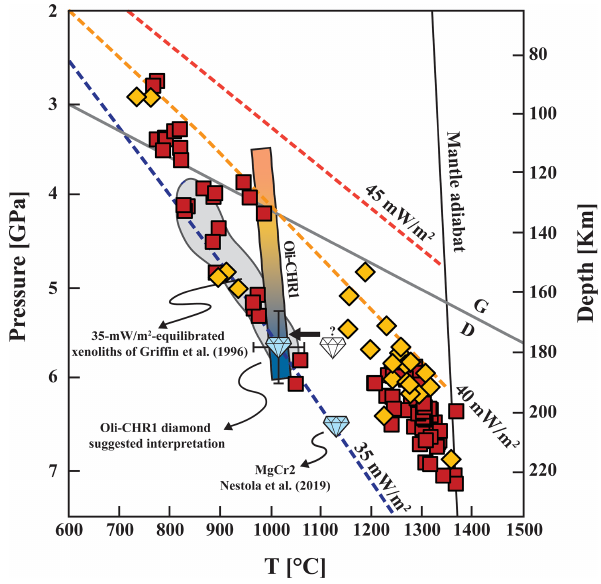
Figure 3. Pressure–temperature diagram showing the distribution of well-equilibrated mantle xenoliths from Udachnaya kimberlite (data source: Tables S1–S2). Red squares indicate the most recent P – T data from Liu et al. (2022), which include a new suite of garnet peridotite xenoliths as well as literature data (see Table S1); these data are based on a carefully selected set of well-equilibrated sam- ples and robust thermobarometers. Yellow rhombi show the data from Goncharov et al. (2012) and Yaxley et al. (2012), for which ro- bust P – T estimates were re-determined following Liu et al. (2022) (see Table S2). P – T conditions for the MgCr2 diamond–mchr pair from Nestola et al. (2019) and 35mWm − 2 equilibrated xenoliths from Griffin et al. (1996, and references therein) are also reported. The gradient bar indicates the P – T equilibration curve (see text) for the studied mchr–olivine inclusion pair; the diamond marker shows the suggested interpretation for our Oli-CHR1 diamond (see text), although entrapment at higher ( ∼ 100 ◦ C) T and re-equilibration during mantle storage cannot be excluded a priori. The 35, 40 and 45mWm − 2 conductive geotherms for the lithospheric mantle and the 1300 ◦ C mantle adiabat are from Hasterok and Chapman (2011); the graphite–diamond (G–D) transition is from Day